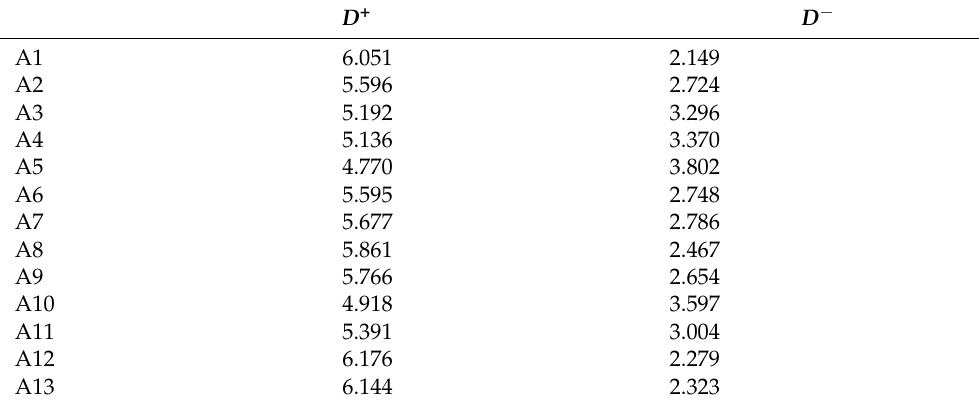
Table 7. Distances between